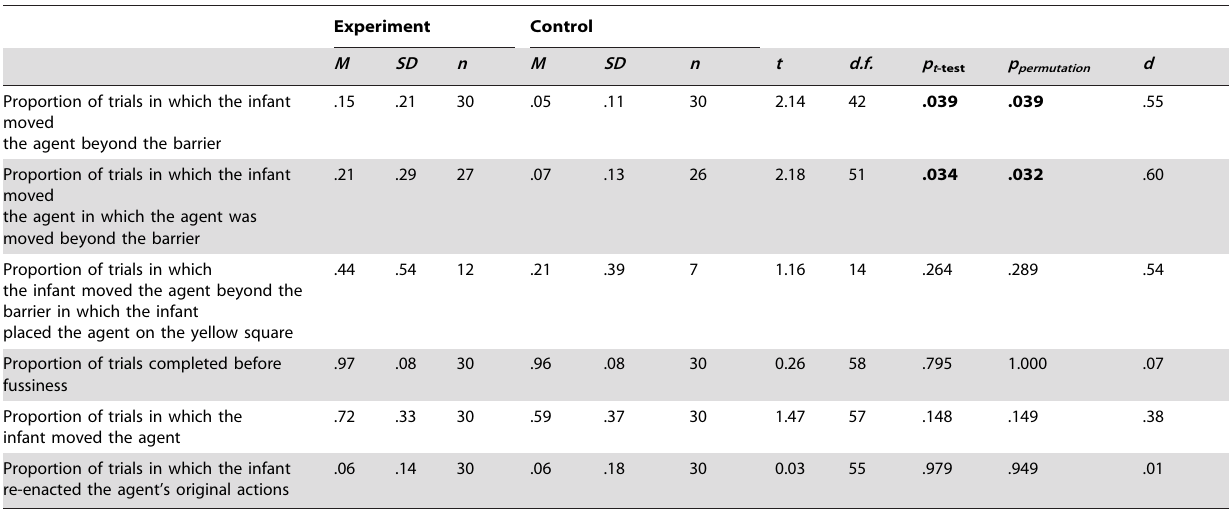
Table 1. Proportions of trials containing specific